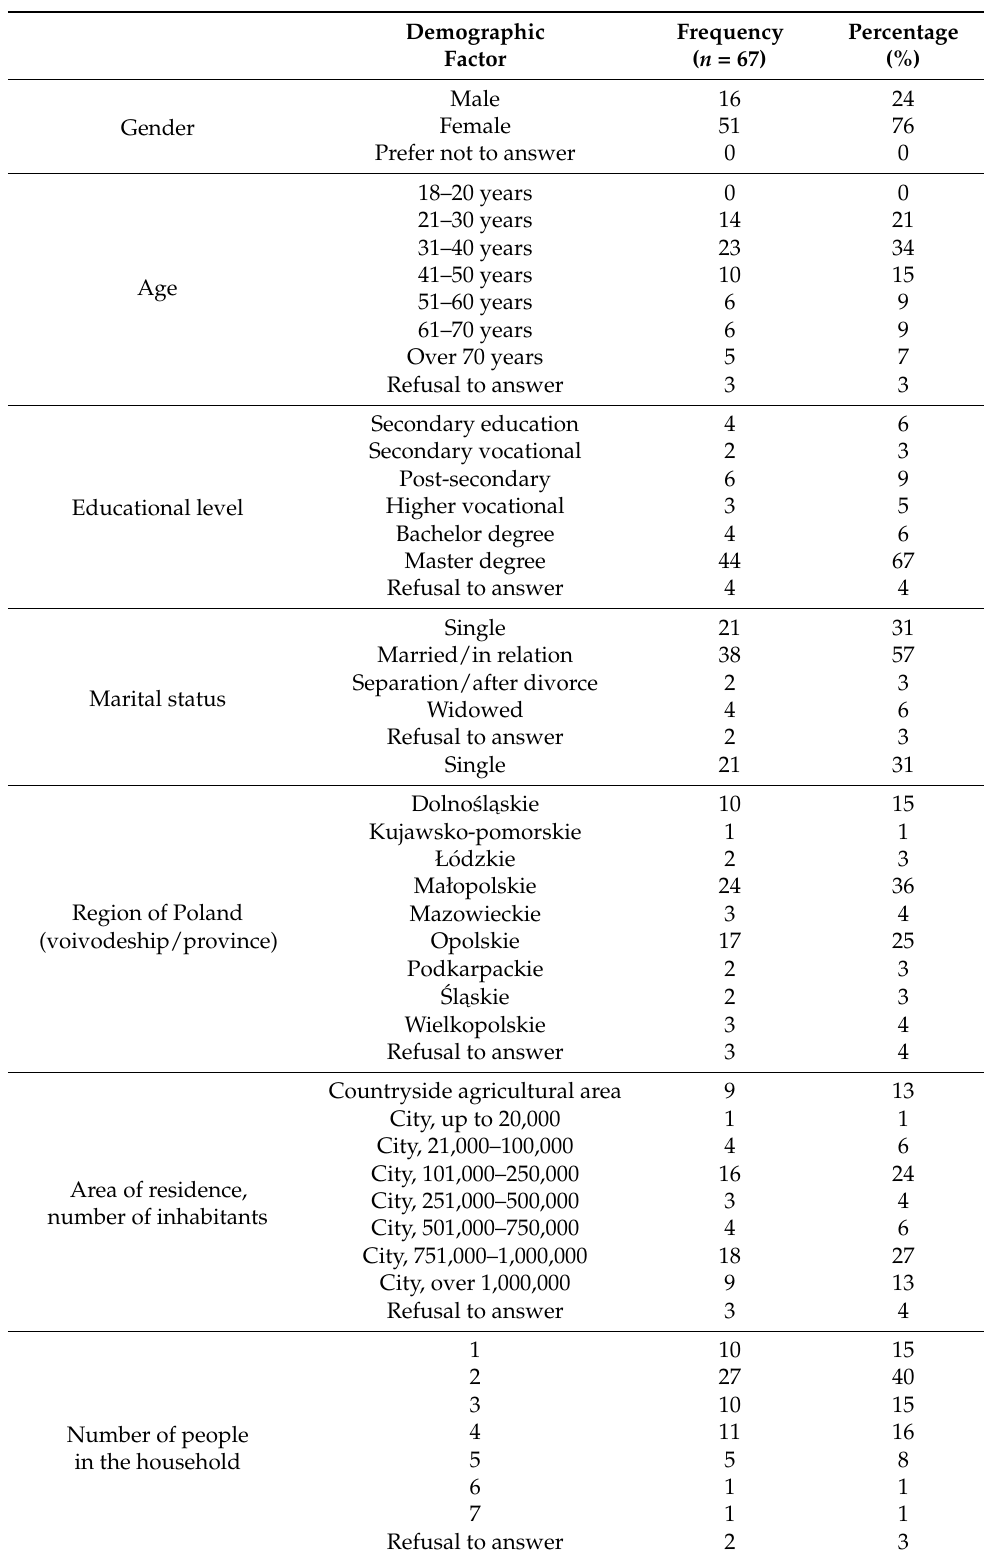
Table 1. Sociodemographic characteristic of Polish